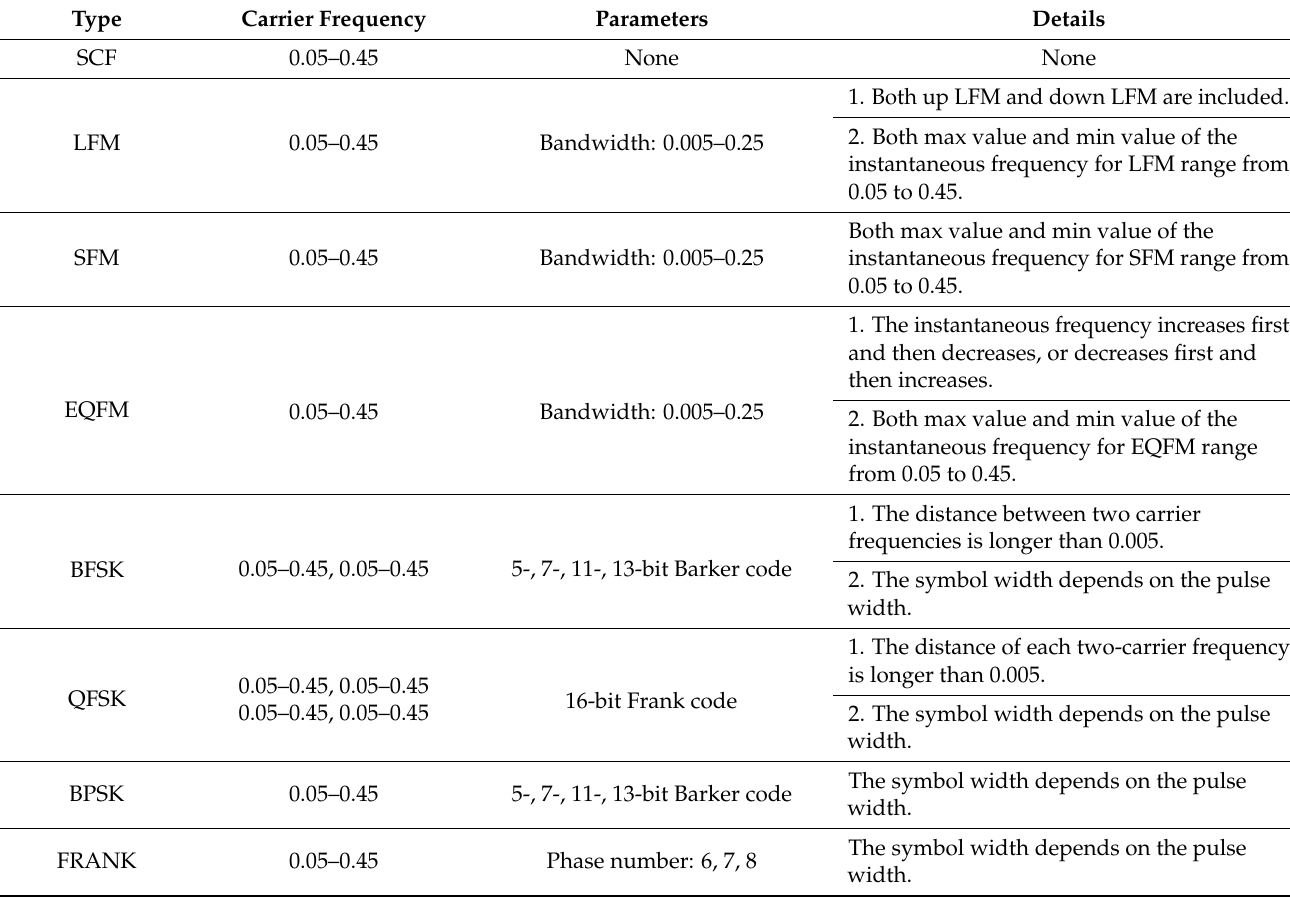
Table 1. Parameters of eight single-component intra-pulse